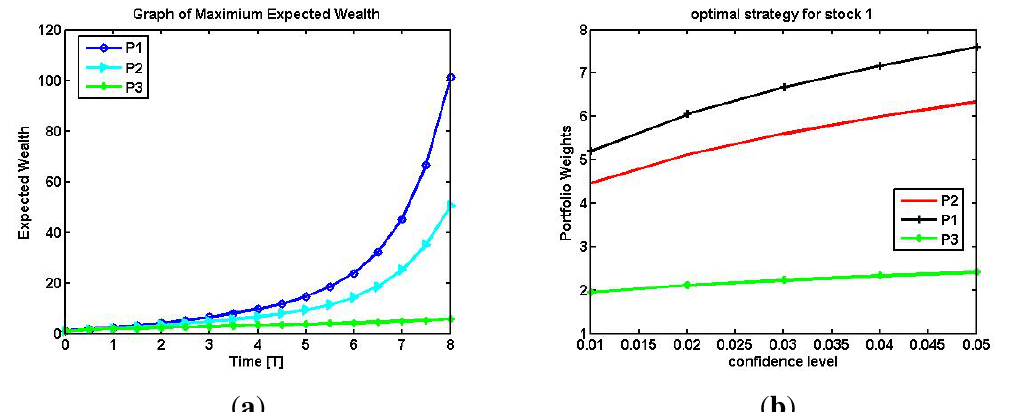
Figure 2. ( a ) Expected return (upper left); ( b ) Optimal strategy with various confidence levels (upper